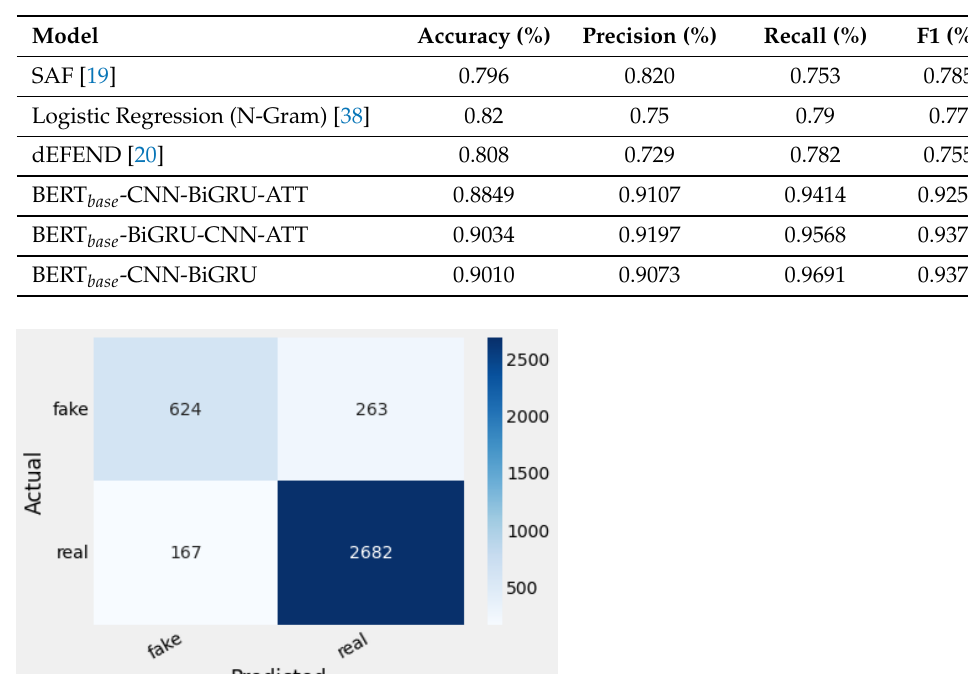
Figure 7. Performance comparisons (%) of all models in PolitiFact. Table 3. Comparison (%) of the results obtained in the GossipCop dataset using news content and user posting behavior features.